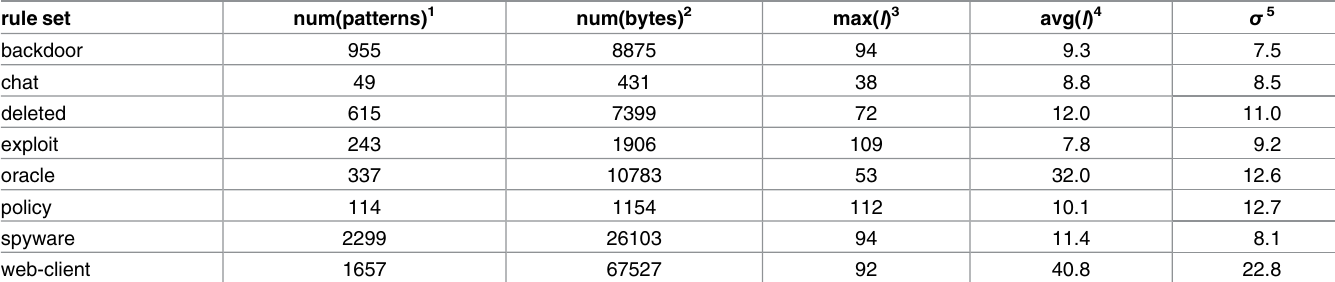
Table 1. Characteristics of rule sets with target